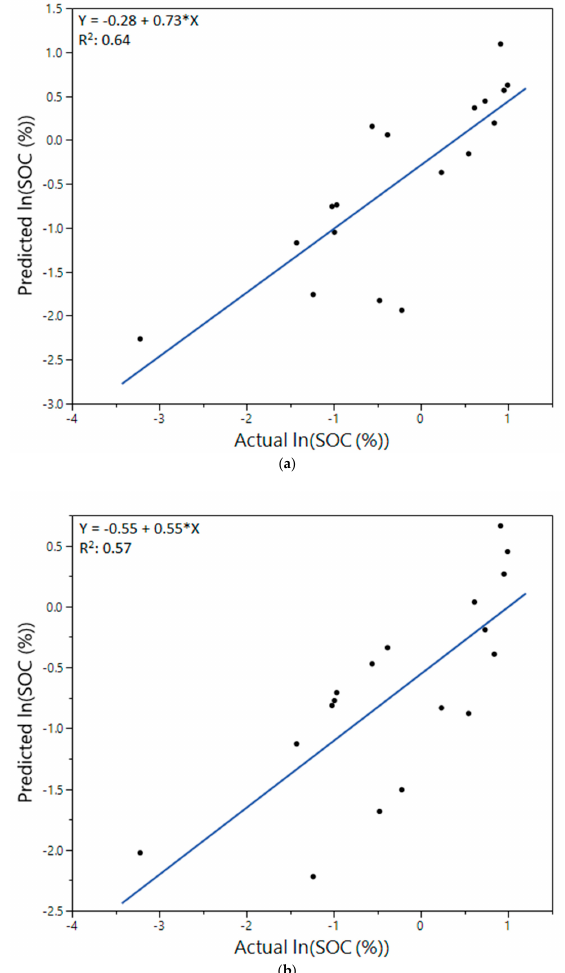
Figure 6. Plots of predicted lnSOC (%) content versus actual lnSOC (%) content for validation data sets for dry soil samples of Entisols using ( a ) models which included depth and color variables ( p -value < 0.001), and ( b ) models which included only color variables as predictors ( p -value <